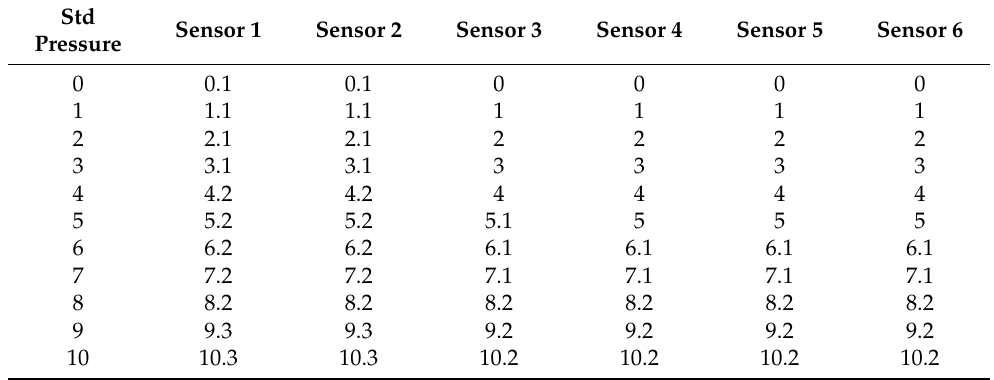
Table 4. Pressure sensor calibration